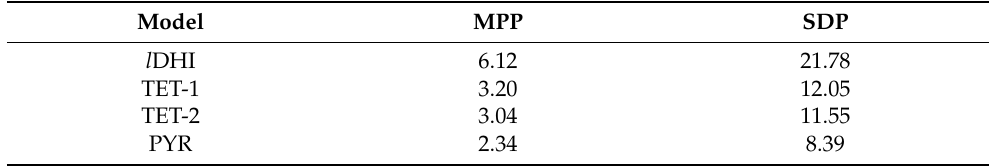
Table 1. Values obtained for the planarity parameters (MPP and SDP), averaged for the oligomeric units for the three MD trajectories in solution for the nanosphere models for the four candidates considered for